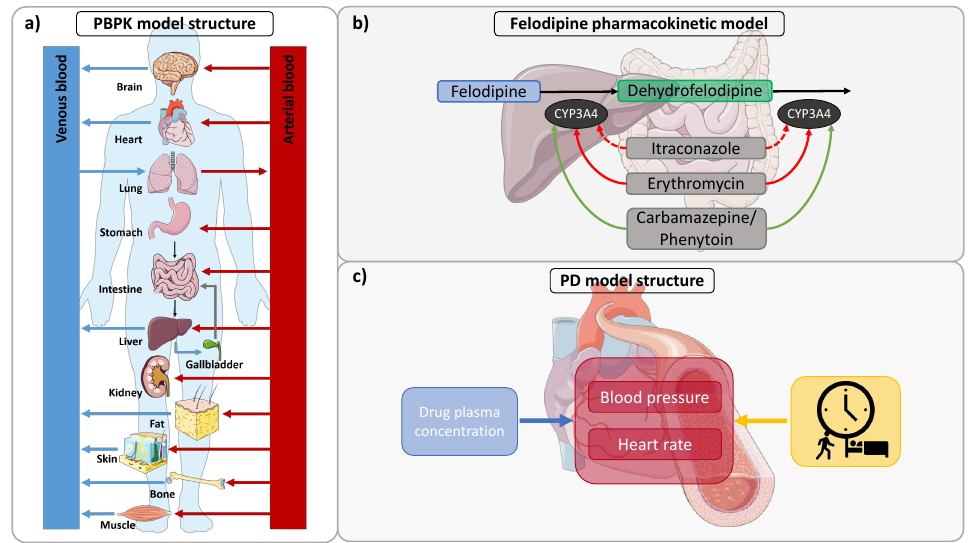
Figure 1. ( a ) Structure of a whole-body PBPK model. In this multi-compartmental modeling approach, compartments represent ADME-relevant organs of the body. The compartments are interconnected with arterial (red arrows) and venous (blue arrows) blood flows. ( b ) Metabolic pathways of felodipine and dehydrofelodipine and DDI network. Felodipine is metabolized by CYP3A4 to dehydrofelodip- ine, which is also metabolized by CYP3A4 (black arrows). Itraconazole and erythromycin are competitive (dotted red arrow) and mechanism-based (red arrow) inhibitors of CYP3A4, respectively, and inhibit the metabolism of felodipine and its metabolite, while carbamazepine and phenytoin induce CYP3A4. ( c ) Structure of the PBPK/PD model extension. Blood pressure and heart rate undergo diurnal variations (yellow). Alterations in diastolic blood pressure and heart rate are di- rectly correlated to felodipine plasma concentrations (blue). Drawings by Servier, licensed under